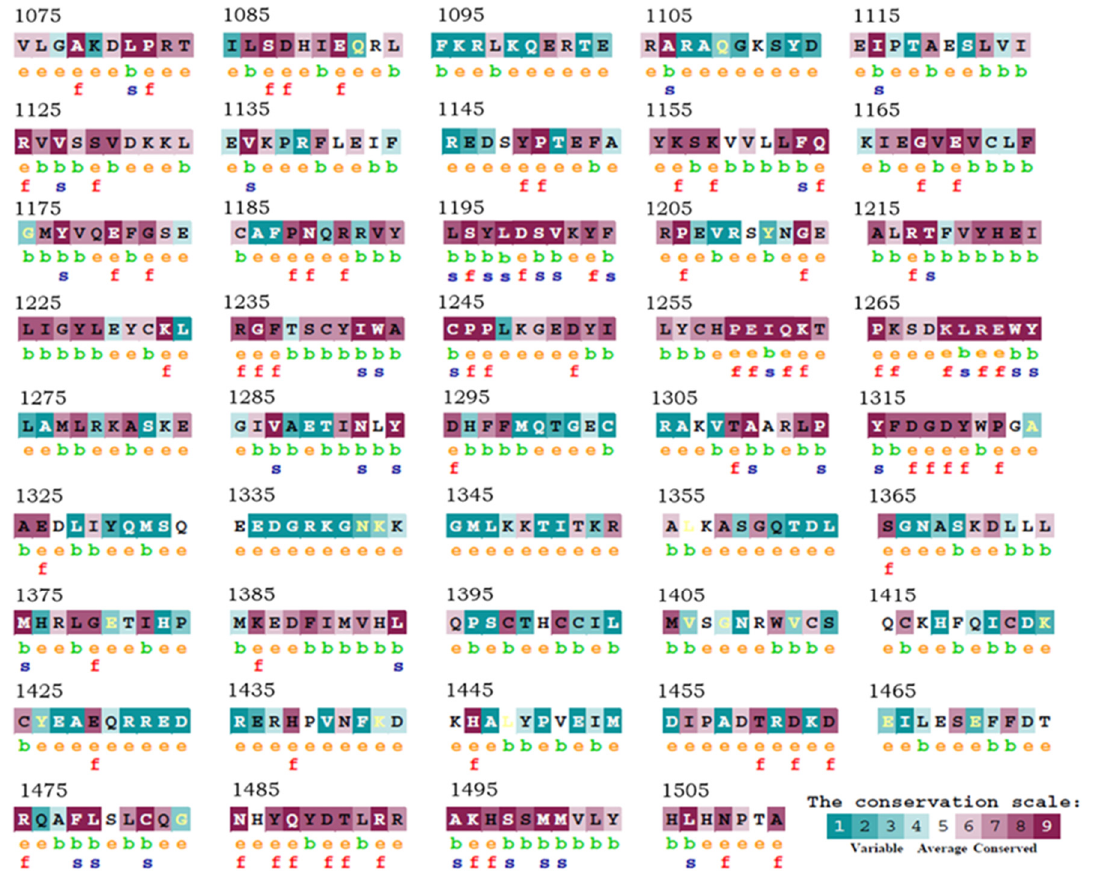
Figure 3. Identification of structurally and functionally conserved amino acid positions. Each residue of the catalytic subunit of Arabidopsis HAC1 is identified by a color representing the degree of evolutionary conservation, cyan to purple, corresponding to variable (grade 1) through conserved (grade 9) positions (first line, uppercase). Below each amino acid is reported the position in the 3D structure of the residue (second line, b and e), and the predicted functionality (third line, f and s). e corresponds to an exposed residue according to the neural network algorithm, b to a buried residue according to the neural network algorithm, f to a predicted functional residue (highly conserved and exposed), s to a predicted structural residue (highly conserved and buried)